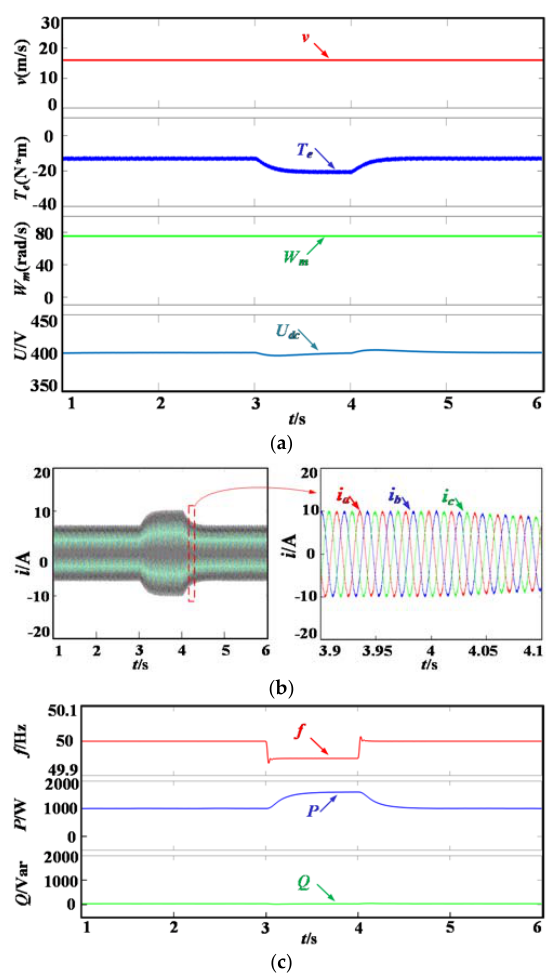
Figure 7. Wind-speed influence on generator-side and grid-side parameters. ( a ) Active and reactive power; ( b ) grid-side three-phase current, current local magnification.